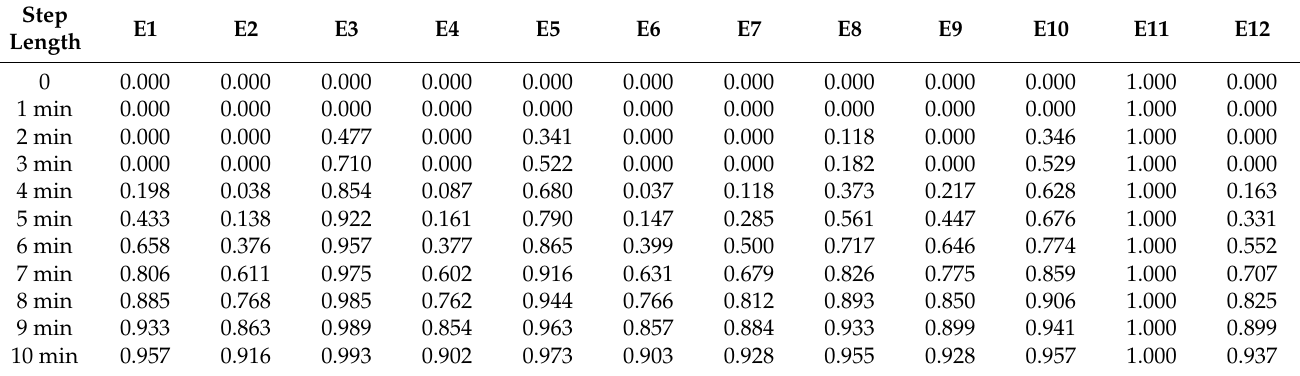
Table 6. Fire probability of equipment in an engine room at each time step when the initial fire source is E11.